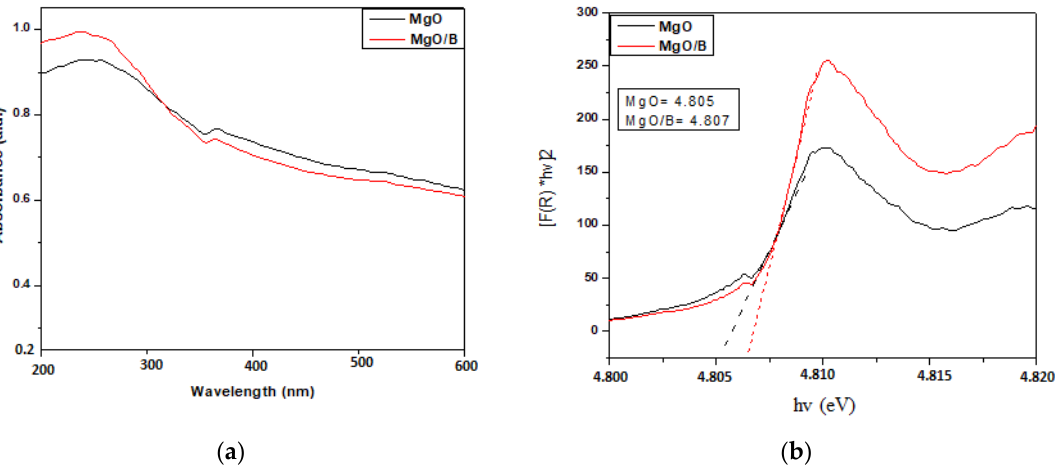
Figure 5. MgO and MgO/Ben optical absorption spectra ( a ); Tauc plots and estimated band gaps of the synthesized materials ( b ).